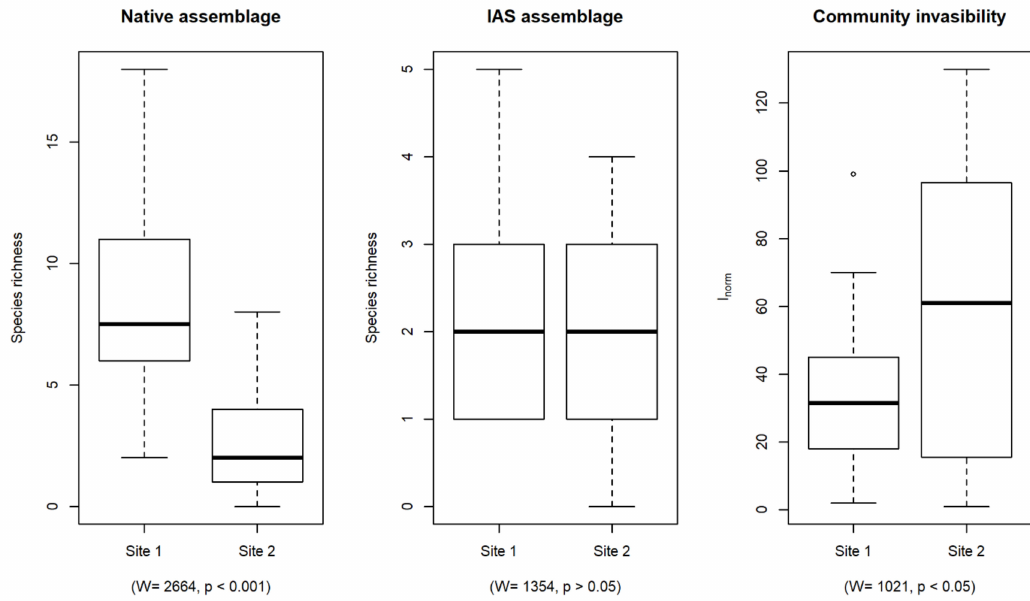
Figure 1. Boxplots of the variation of native, invasive species richness and community invasibility in the two sampling sites. Wilcoxon rank-sum tests were also reported. IAS = Invasive Alien